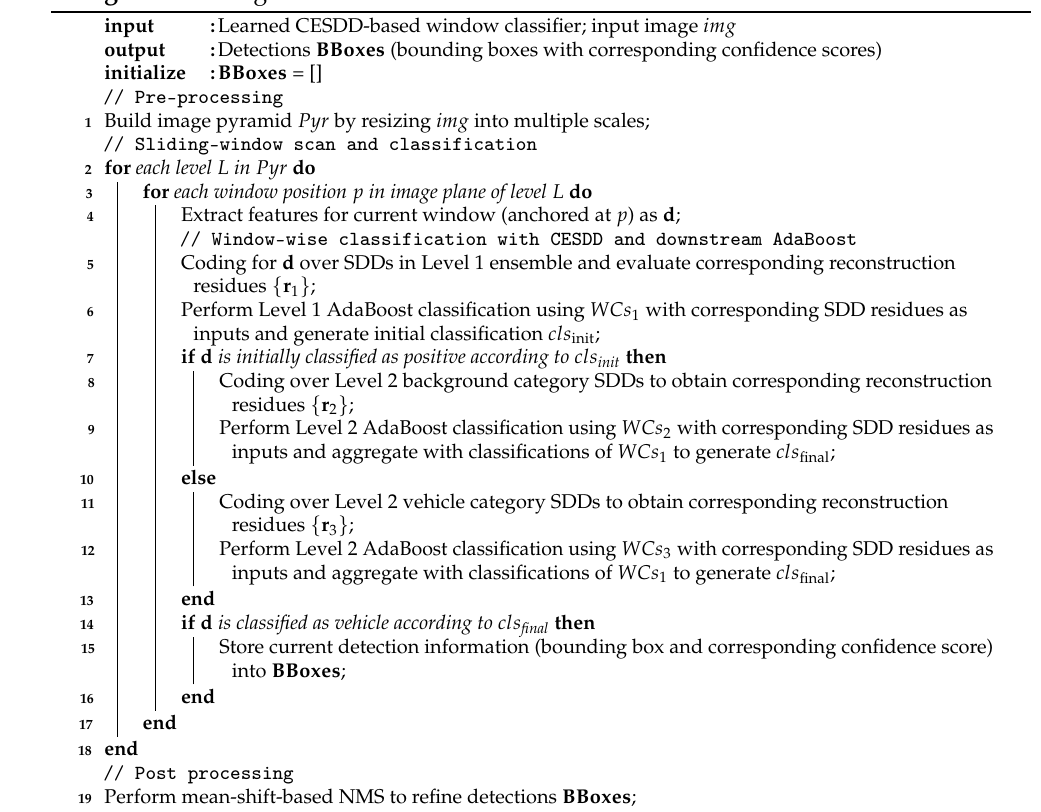
Algorithm 2: Algorithm of vehicle detection with